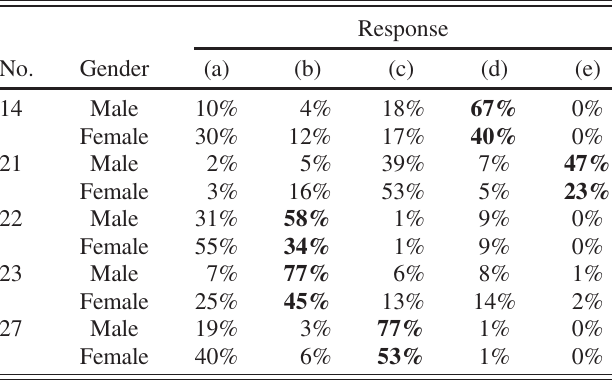
TABLE V. Answer distribution for problems with large gender differences in CTT and IRT difficulty in Sample 1. Correct answers are